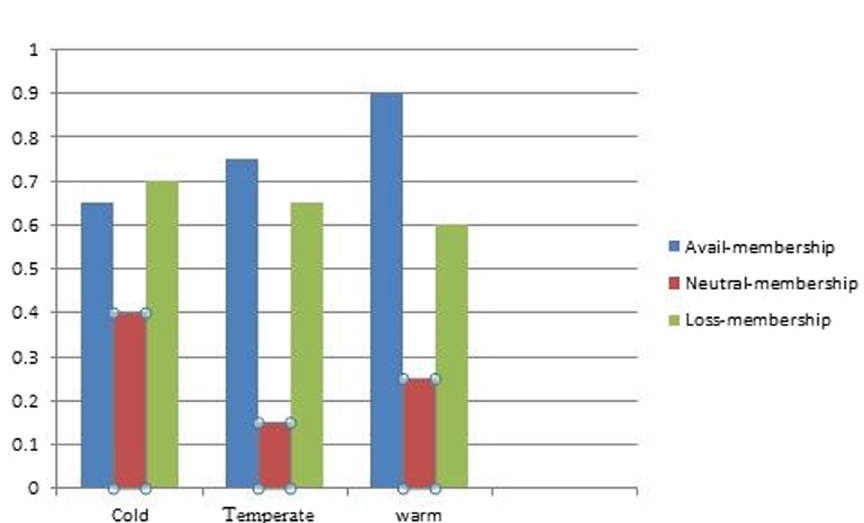
Fig. 9 Comparison of the energy of